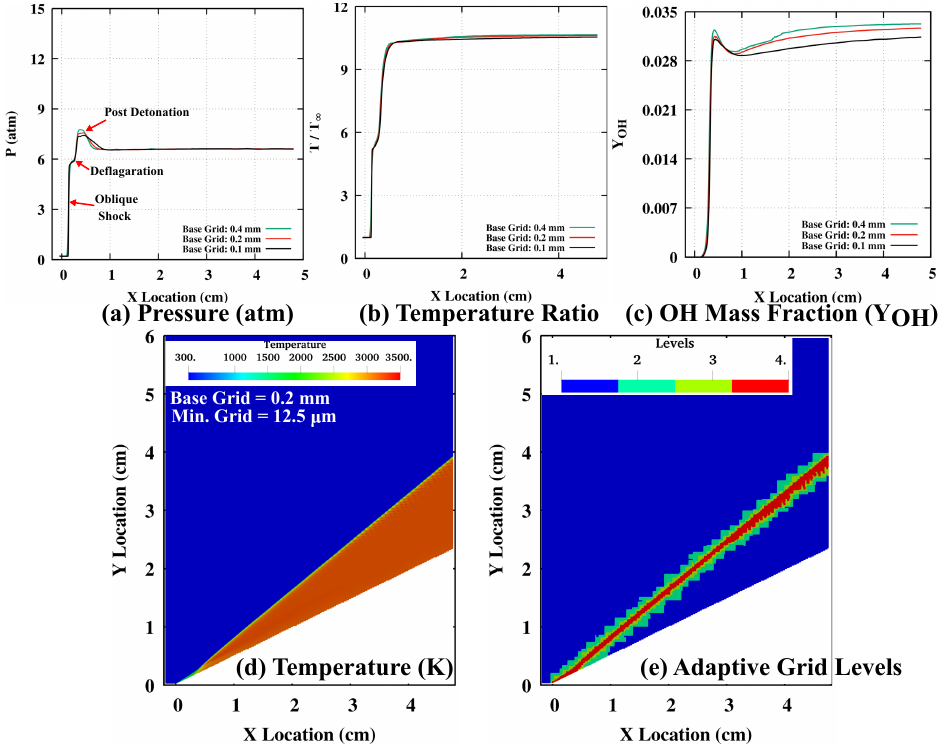
Figure 3. Mach 9 with 10,000 PPM O 3 addition: ( a ) Pressure, ( b ) temperature and ( c ) OH mass fraction variation at lines parallel to the wedge for all three grids; ( d ) Temperature and ( e ) adaptive grid levels for a medium